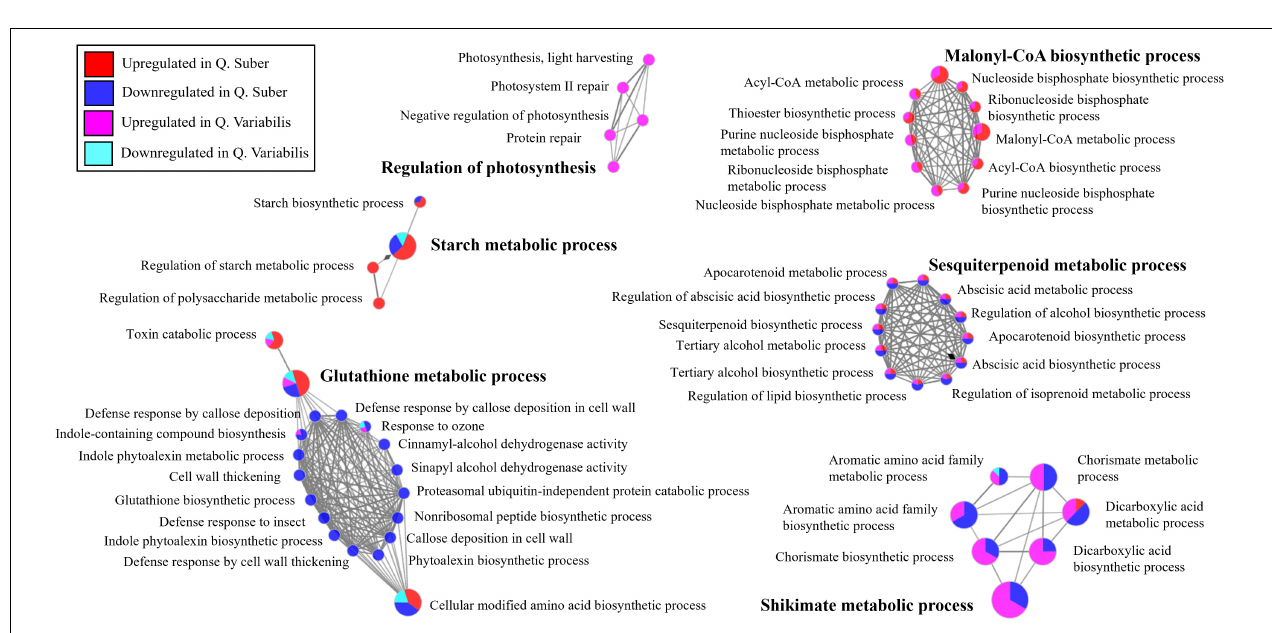
FIGURE 7 | Functionally annotated biological process network constructed by ClueGO at kappa score ≥ 0.4 for leaf proteins affected in Q. suber and Q. variabilis 36 h after inoculation with P. cinnamomi .